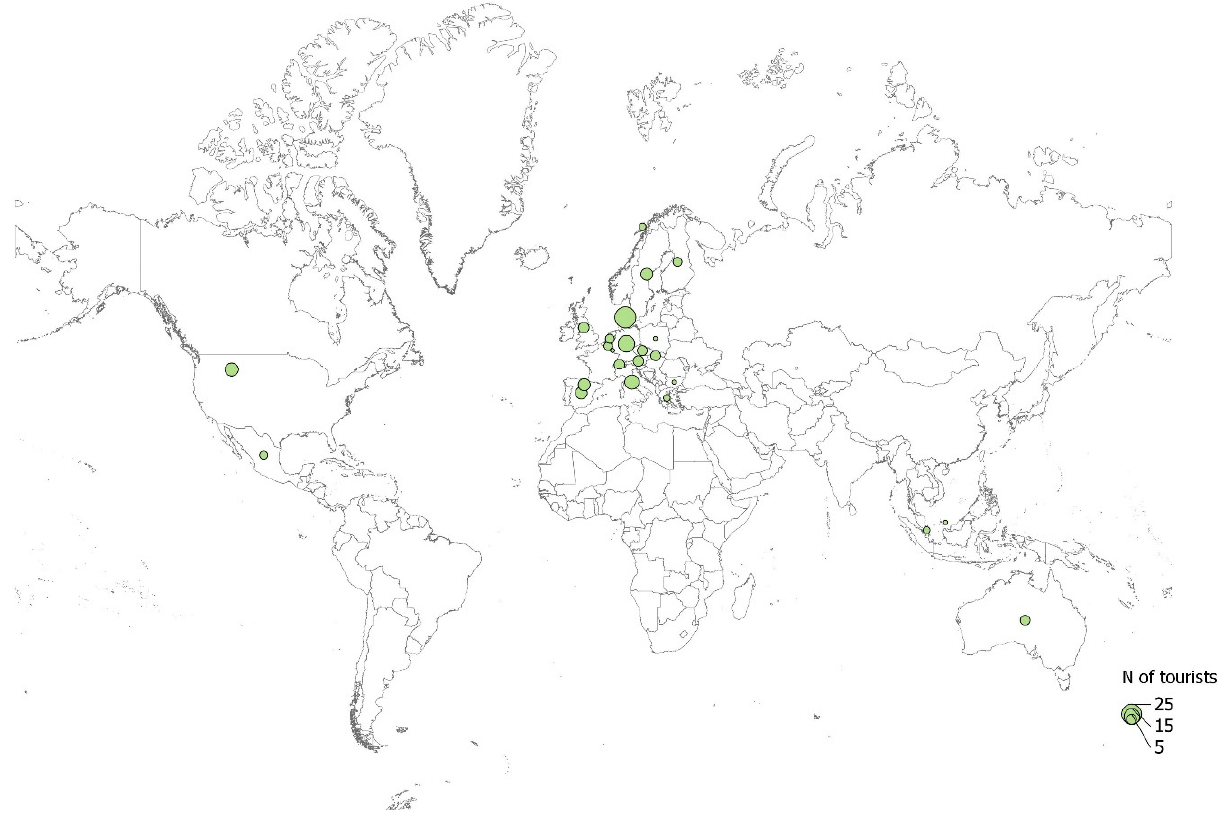
Figure 1. Geographical representation of tourists arriving in the Faroe Islands. Own elaboration, QGIS 3.22.3. Table 2. Pre-and post-experience destination image of the Faroe Islands, PS Imago Pro, own elaboration.